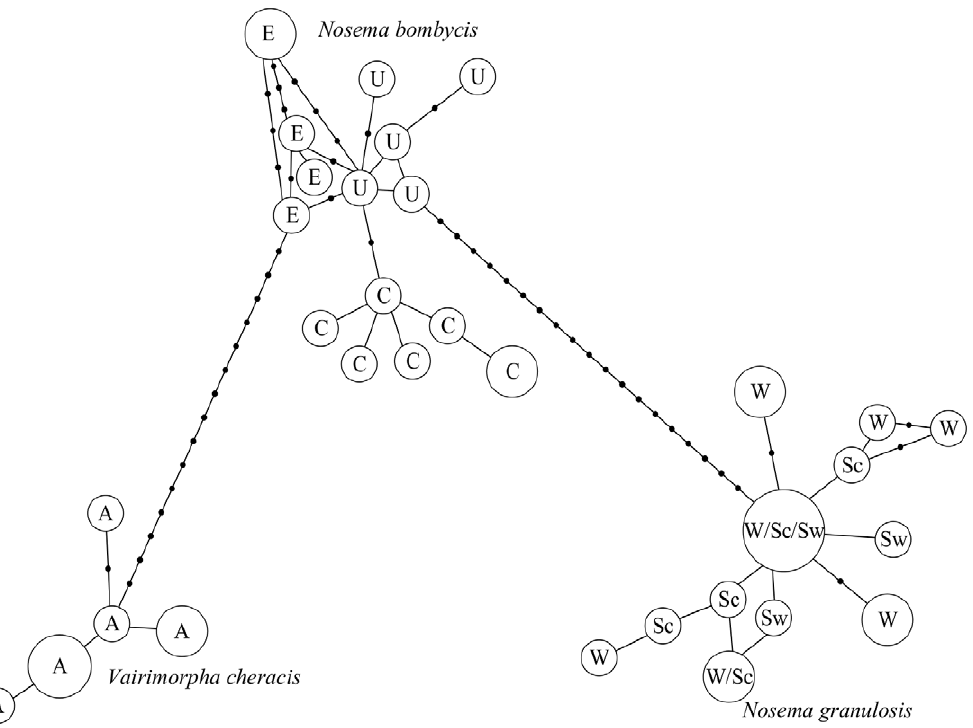
Figure 5. Haplotype network of cloned rDNA sequences containing the IGS and flanking 16S and 5.8S rDNA regions of N.bombycis , N.granulosis and V.cheracis isolates. Branch lengths are proportional to the number of mutations separating haplotypes. Areas of circles are proportional to the number of clones containing each haplotype. Isolates are labelled as follows: A= V. cheracis (Australia), E= N. bombycis (England), U= N. bombycis (USA), C= N. bombycis (China), W= N. granulosis (Wales), Sc= N. granulosis (Scotland), Sw= N. granulosis